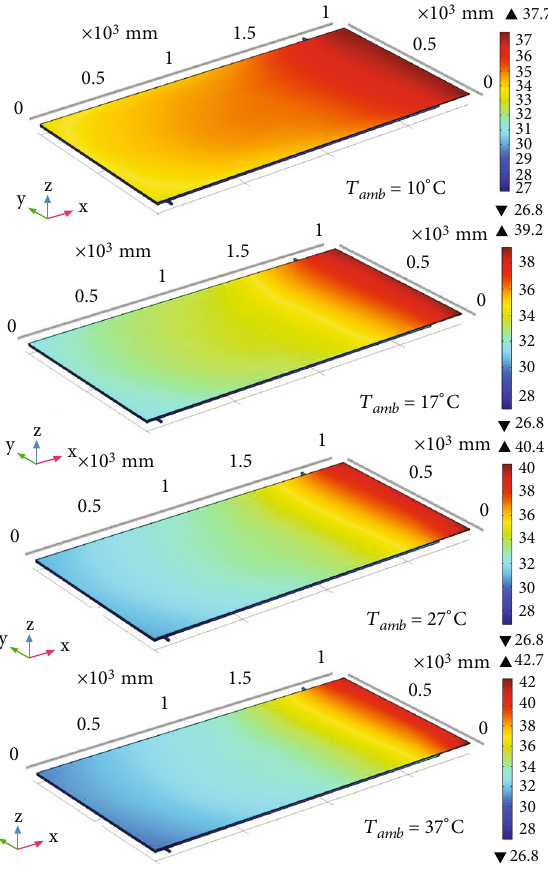
Figure 8: Outcome of ambient temperature on PVT surface temperature with G = 500W/m 2 , V